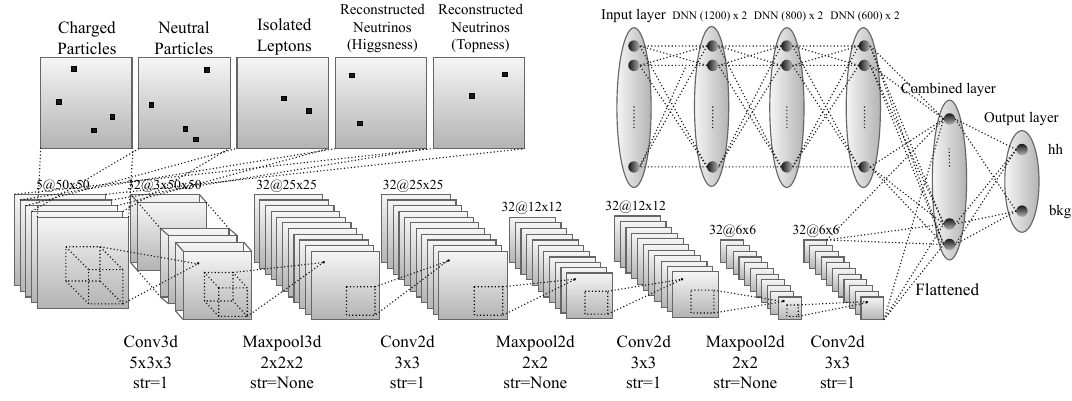
Figure 4 . A schematic architecture of the convolutional neural network (CNN) used in this paper. The separate DNN chain in the right-upper corner is used only when the kinematic variables are